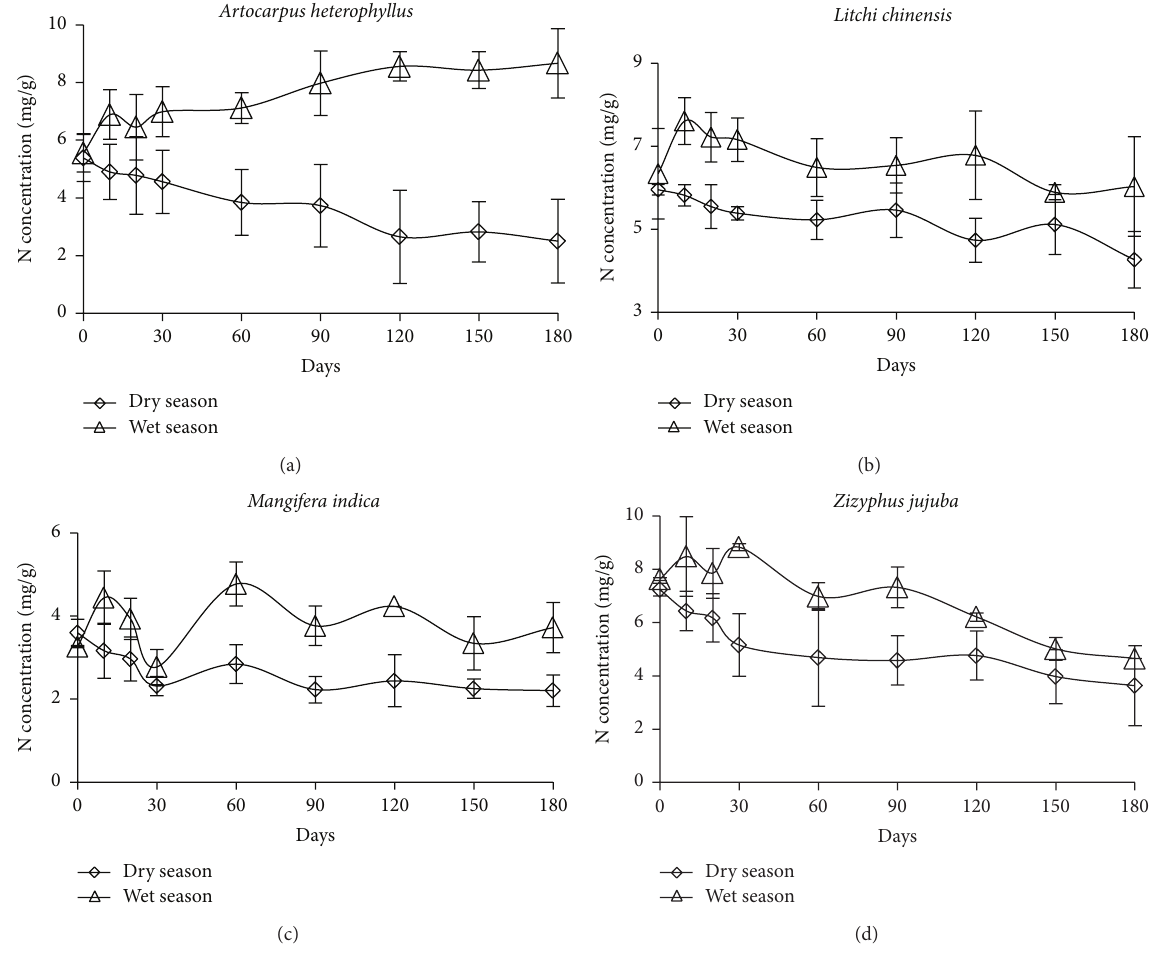
Figure 2: Rate of decomposition of leaf litter of four tree species used in agroforestry during the dry and wet seasons over 180-day periods.